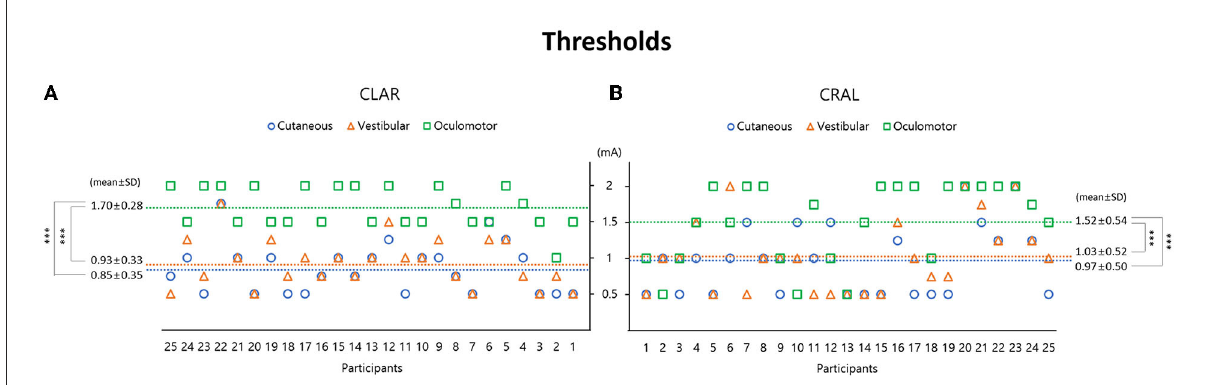
FIGURE2 Galvanic vestibular stimulation (GVS) thresholds are presented separately: cutaneous and vestibular perceptions and oculomotor response using two stimulating paradigms of the cathode on the left and anode on the right (CLAR) (A) and the cathode on the right and anode on the left (CRAL) (B) . In the CLAR paradigm, the oculomotor threshold (1.7 ± 0.28mA) was significantly higher than the vestibular perception threshold (0.93 ± 0.33 mA, p < 0.001, Bonferroni test) and cutaneous perception threshold (0.85 ± 0.35mA, p < 0.001, Bonferroni test) (A) . In the CRAL paradigm, the oculomotor threshold (1.52 ± 0.54mA) was also significantly higher than the vestibular perception threshold (1.03 ± 0.52mA, p < 0.001, Bonferroni test) and cutaneous perception threshold (0.97 ± 0.5mA, p < 0.001, Bonferroni test) (B) . GVS threshold values are presented as mean ± standard deviation (mA).